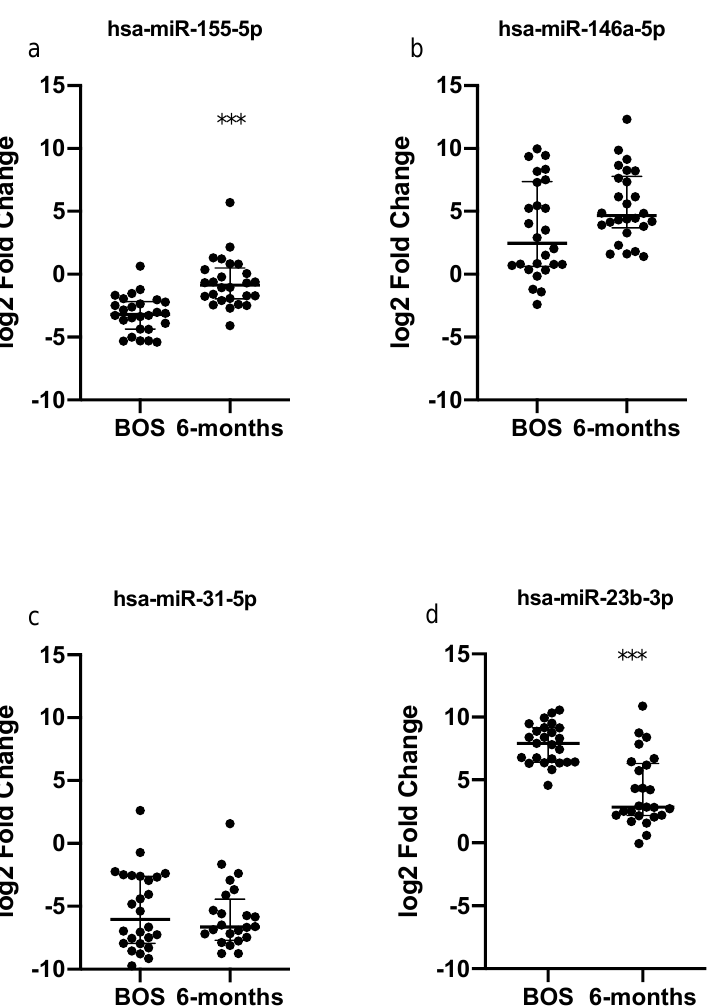
Figure 2. Quantitative expression of ( a ) miR-155, ( b ) miR-146a, ( c ) miR-31 and ( d ) miR-23 in serum of patients before ECP therapy and after 6 months of treatment. Relative expressions were expressed as log2 transformed values. *** p < 0.0001.